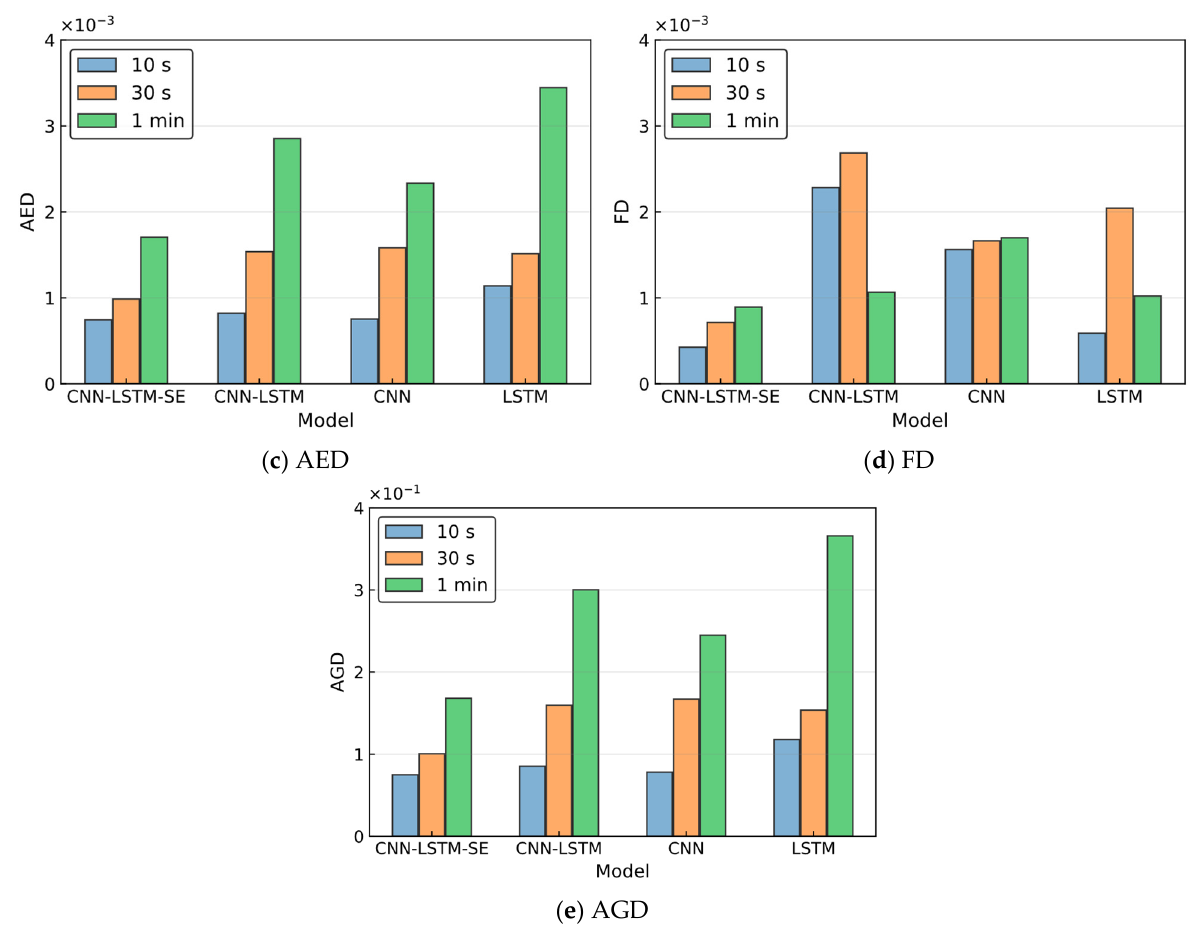
Figure 7. Distribution of evaluation indexes of ship-2.